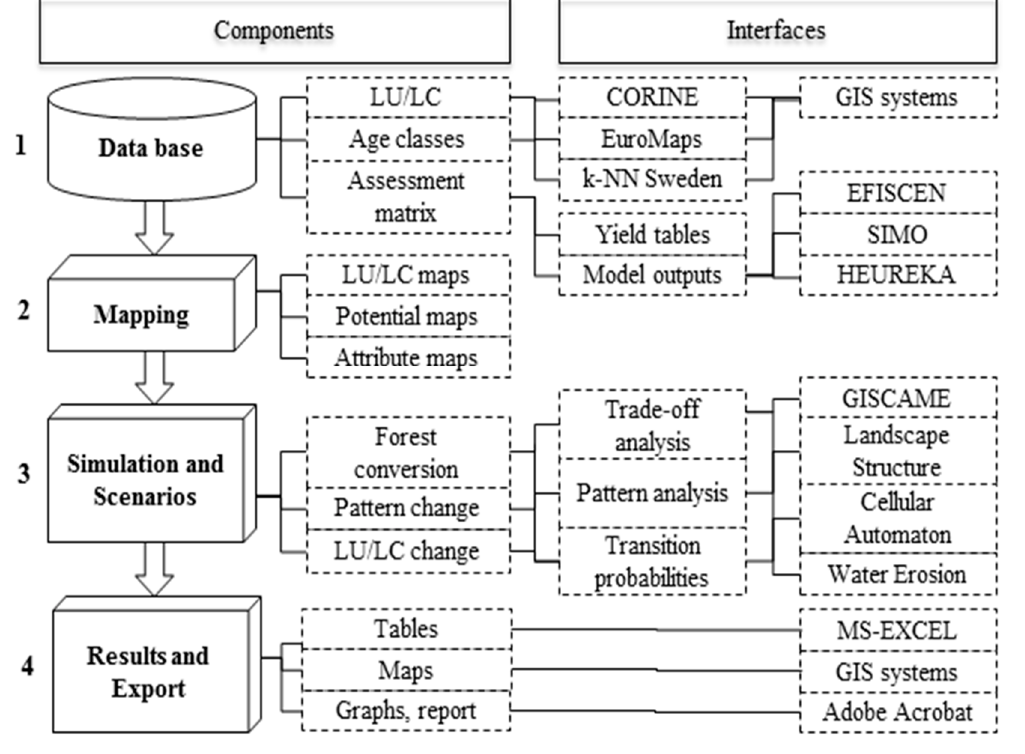
Figure 3. Model architecture of the new Biomass Module, consisting of four parts which are linked to further data, models, or software. LU/LC… land use/land